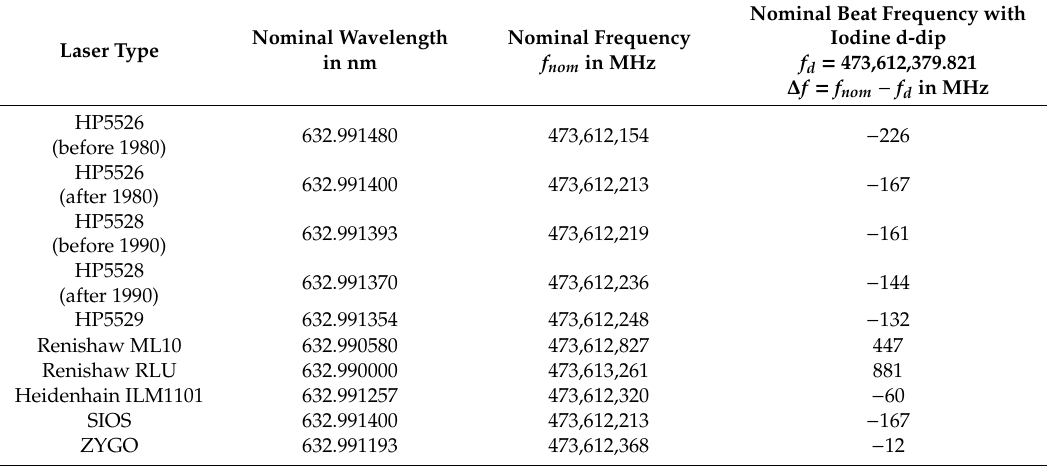
Table 3. Nominal wavelength of several laser types, as used in laser interferometer